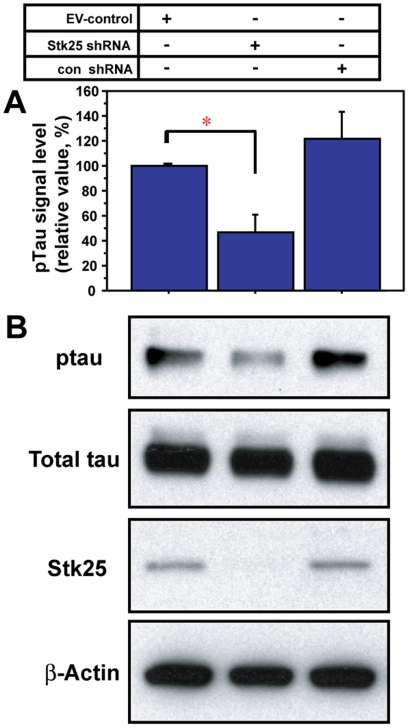
Stk25 knockdown reduces Tau phosphorylation in embryonic neurons.
A Phospho-Tau normalized to total Tau was significantly reduced in primary neurons infected with Stk25 shRNA viruses compared to neurons infected with either an empty vector (EV)-control or the control shRNA (con shRNA). B Tau phosphorylation at pSer202/pThr205 (AT8 antibody, 1st panel) was lower in samples with reduced Stk25 expression (3rd panel), whereas total Tau levels (2nd panel) and β-actin levels (4th panel) were unchanged. (* p<0.05, Student's t test, n = 3).